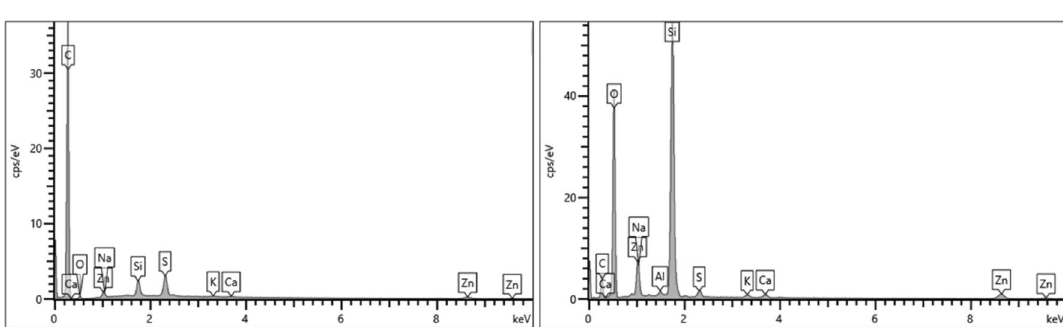
Figure 7. SEM image of rubber powder (left) and TWAP (right) at higher magnification (200x).